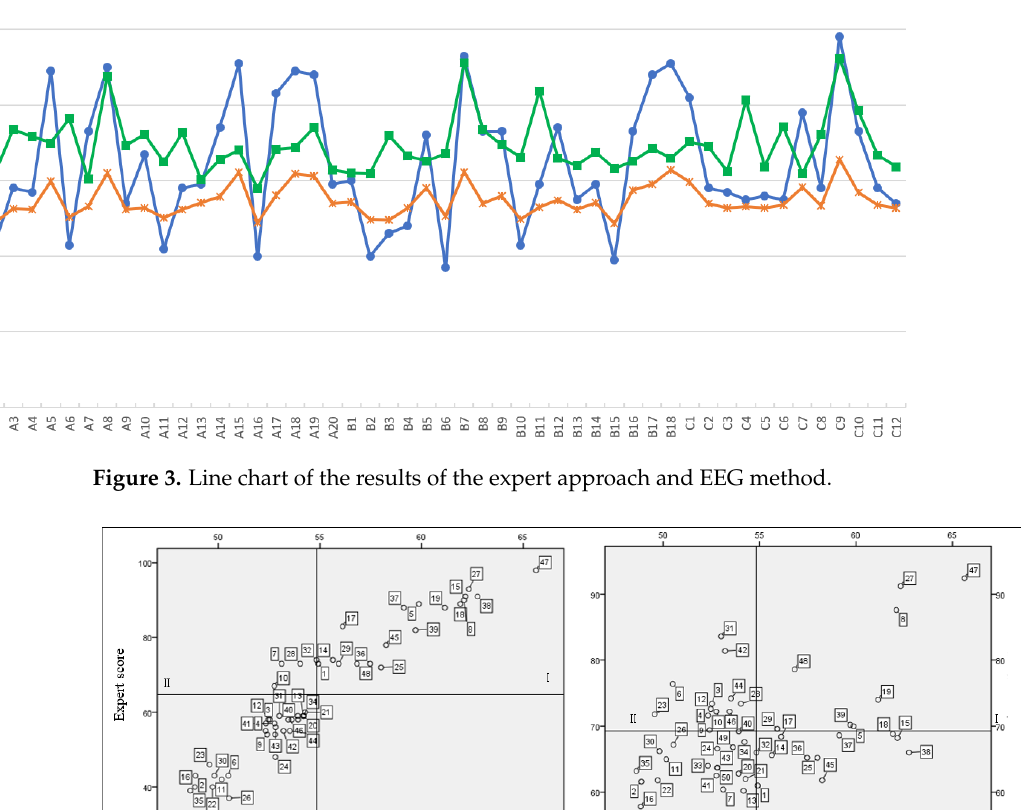
Figure 3. Line chart of the results of the expert approach and EEG method.